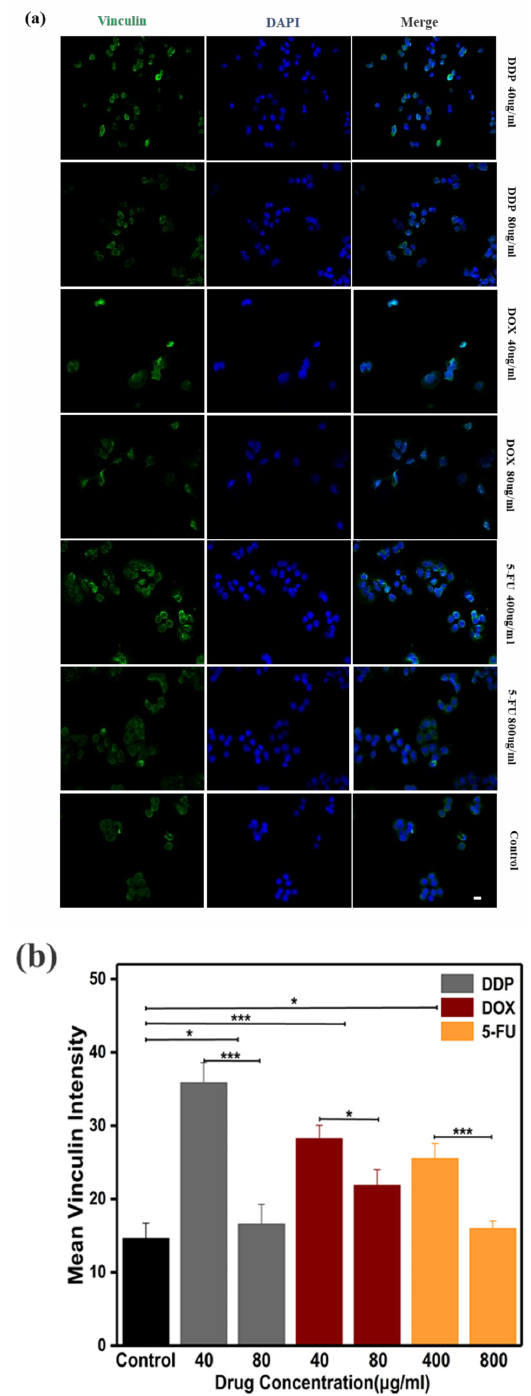
Figure 8. ( a ) Distribution of vinculin of HeLa cells treated by dose-dependent DDP, DOX, and 5-FU for 24 h; vinculin (green), DAPI (blue). ( b ) Average fluorescence intensity of vinculin. Scale bar: 20 µm.